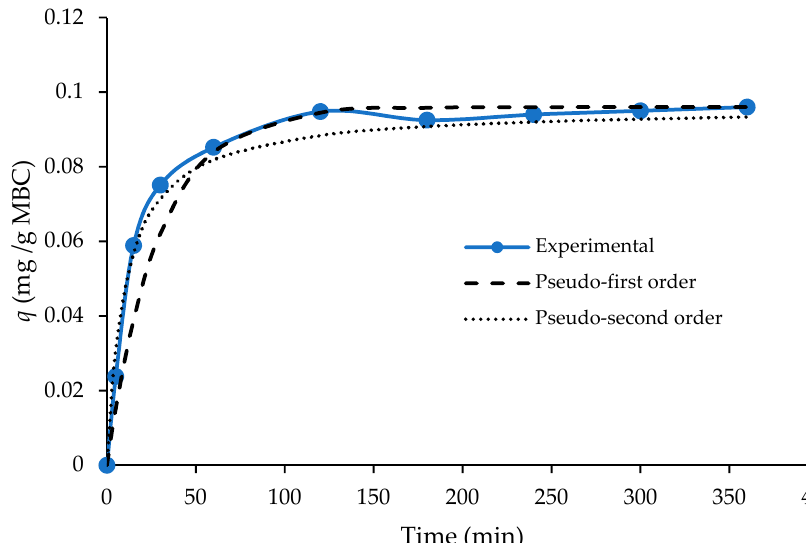
Figure 4. Nitrate adsorption: pseudo-first and -second kinetics vs. experimental. Table 1. Adsorption kinetic models for nitrate removal with MBC prepared at 1000 ℃.